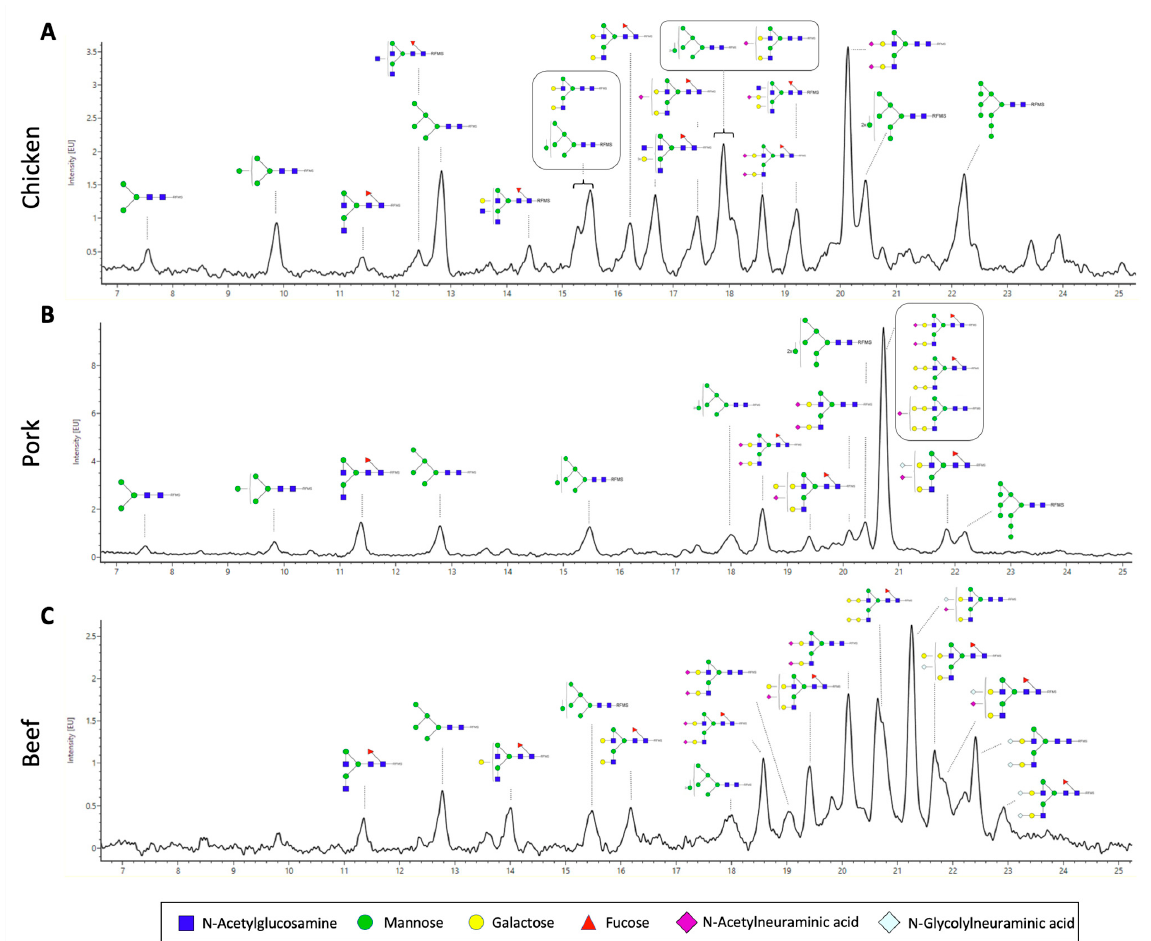
Figure 4. Representative fluorescence (FLR) chromatograms of RFMS-labelled released N-glycans from ( A ) chicken, ( B ) pork, and ( C ) beef. (Blue square, N-Acetylglycosamine; green circle, mannose; yellow circle, galactose; red triangle, fucose; purple diamond, N-acetylneuraminic acid; light blue, N-Glycolylneuraminic acid.) Glycan images represent compositions and linkage type is not deter- mined. (Samples were separated using an ACQUITY UPLC Glycan BEH amide column.) Table 2. Summary of relative abundances of N-glycans detected in chicken, pork, and beef.